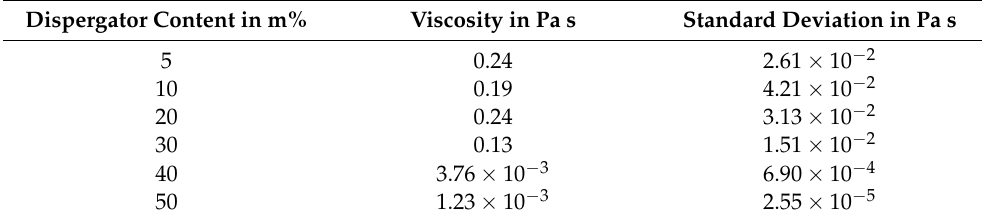
Table A3. Viscosity values as a function of TX-100 content for an aqueous dispersion containing 10 m% graphite nanoparticles at a pH value of 9–9.5.